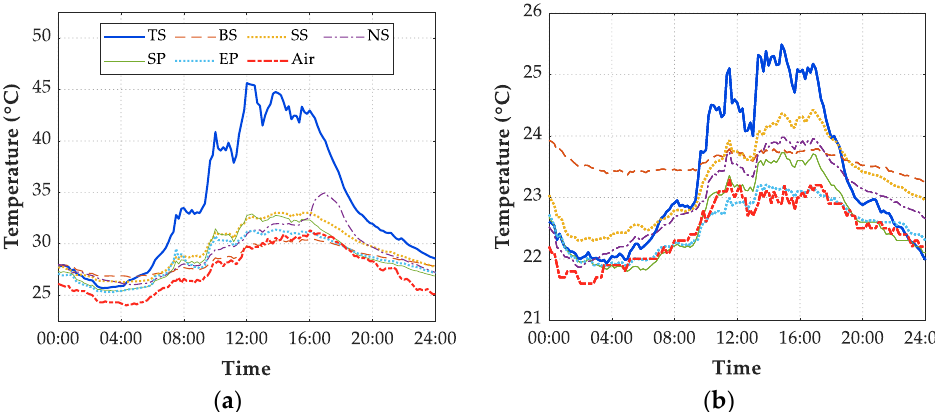
Figure 12. Temperature history of 6 measuring points on the bridge and air. ( a ) 07 July 2019; ( b ) 13 July 2019.